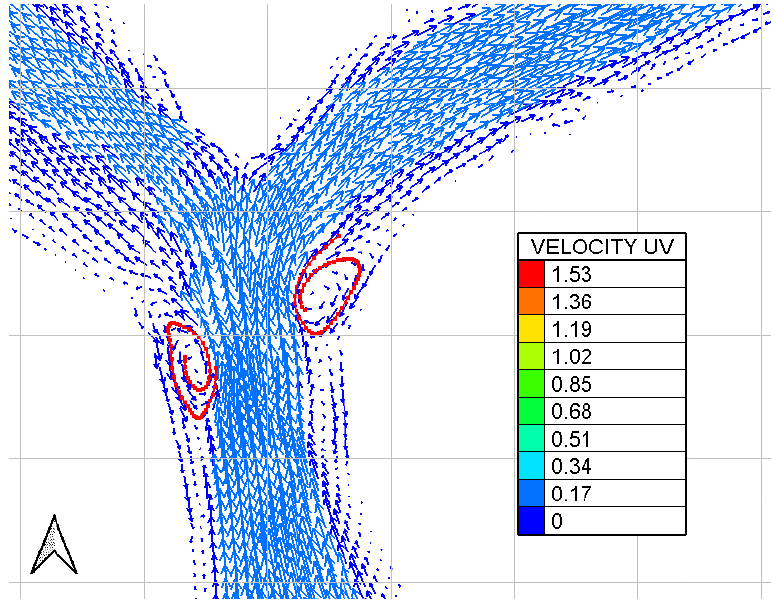
Figure 3. Average flow velocity (VELOCITY UV) in the flood season in 2009 (m/s).